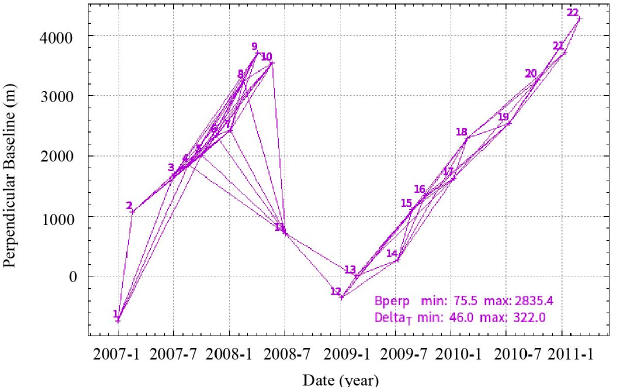
Figure 8. Baseline distribution of interferometric pairs used in this study.